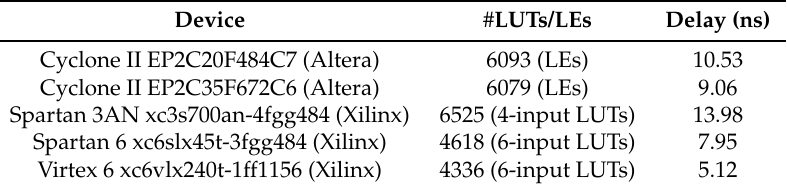
Table 2. Area and delay figures for ECC unit implementation on different